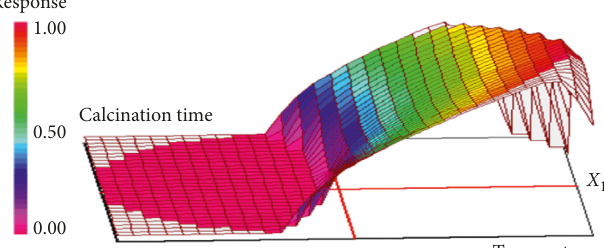
Figure 3: Variation of the function of desirability as a function of calcination temperature and time.